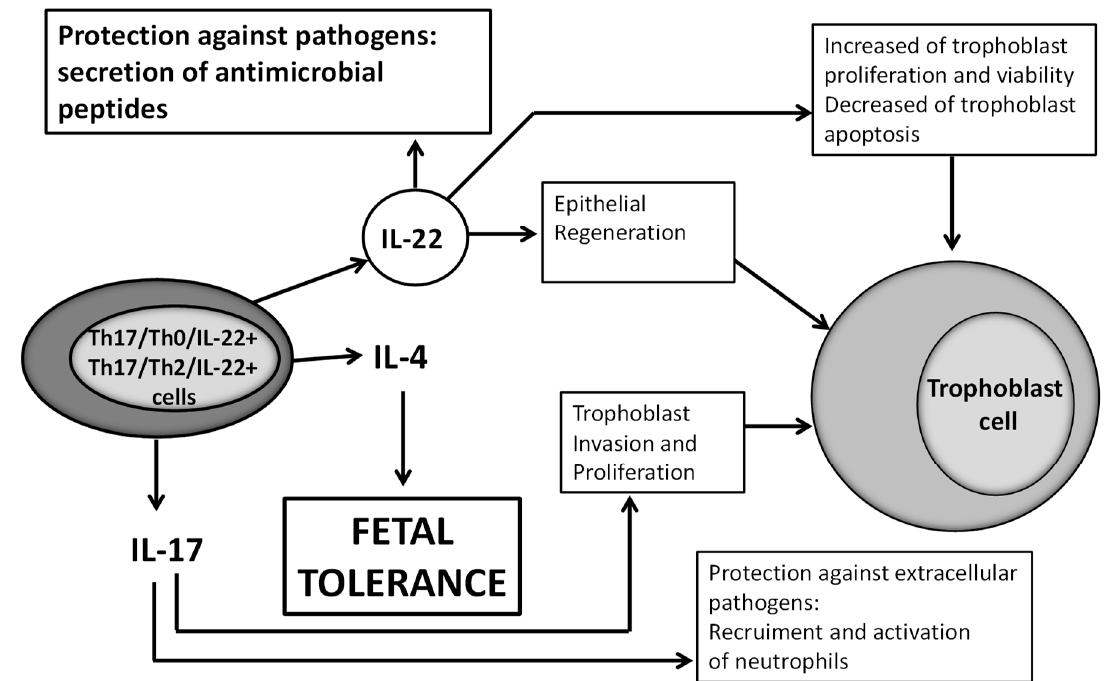
Figure 8. Possible positive roles of Th22/Th2/IL-22+ and Th17/Th0/IL-22+ cells at fetal maternal interface.